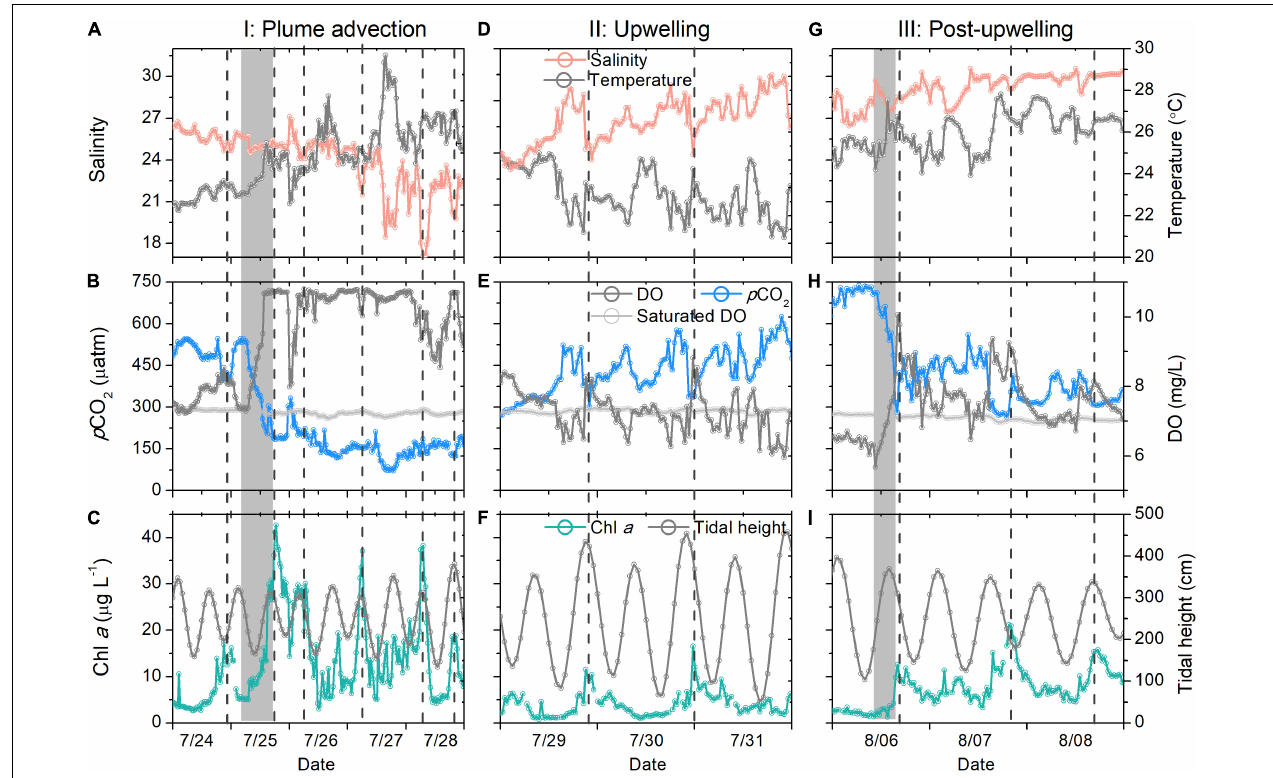
FIGURE 3 | High-temporal-resolution salinity and temperature (A,D,G) , p CO 2 and DO (B,E,H) , Chl a and tidal height (C,F,I) data during the three studied periods. The gray bars in (C,I) denote the sharp p CO 2 decrease. All vertical dashed lines denote the Chl a peaks.